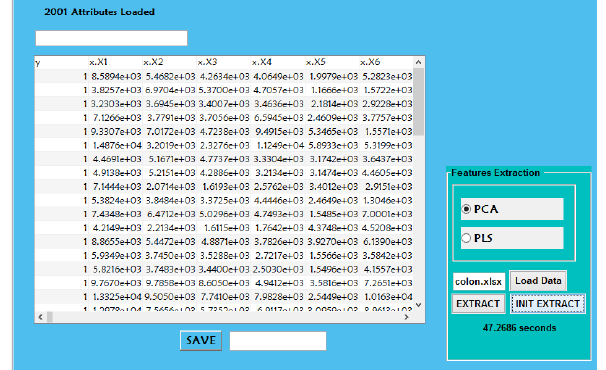
Figure 1: The Loaded Colon Cancer Microarray Dataset. Table 1: Result Evaluations